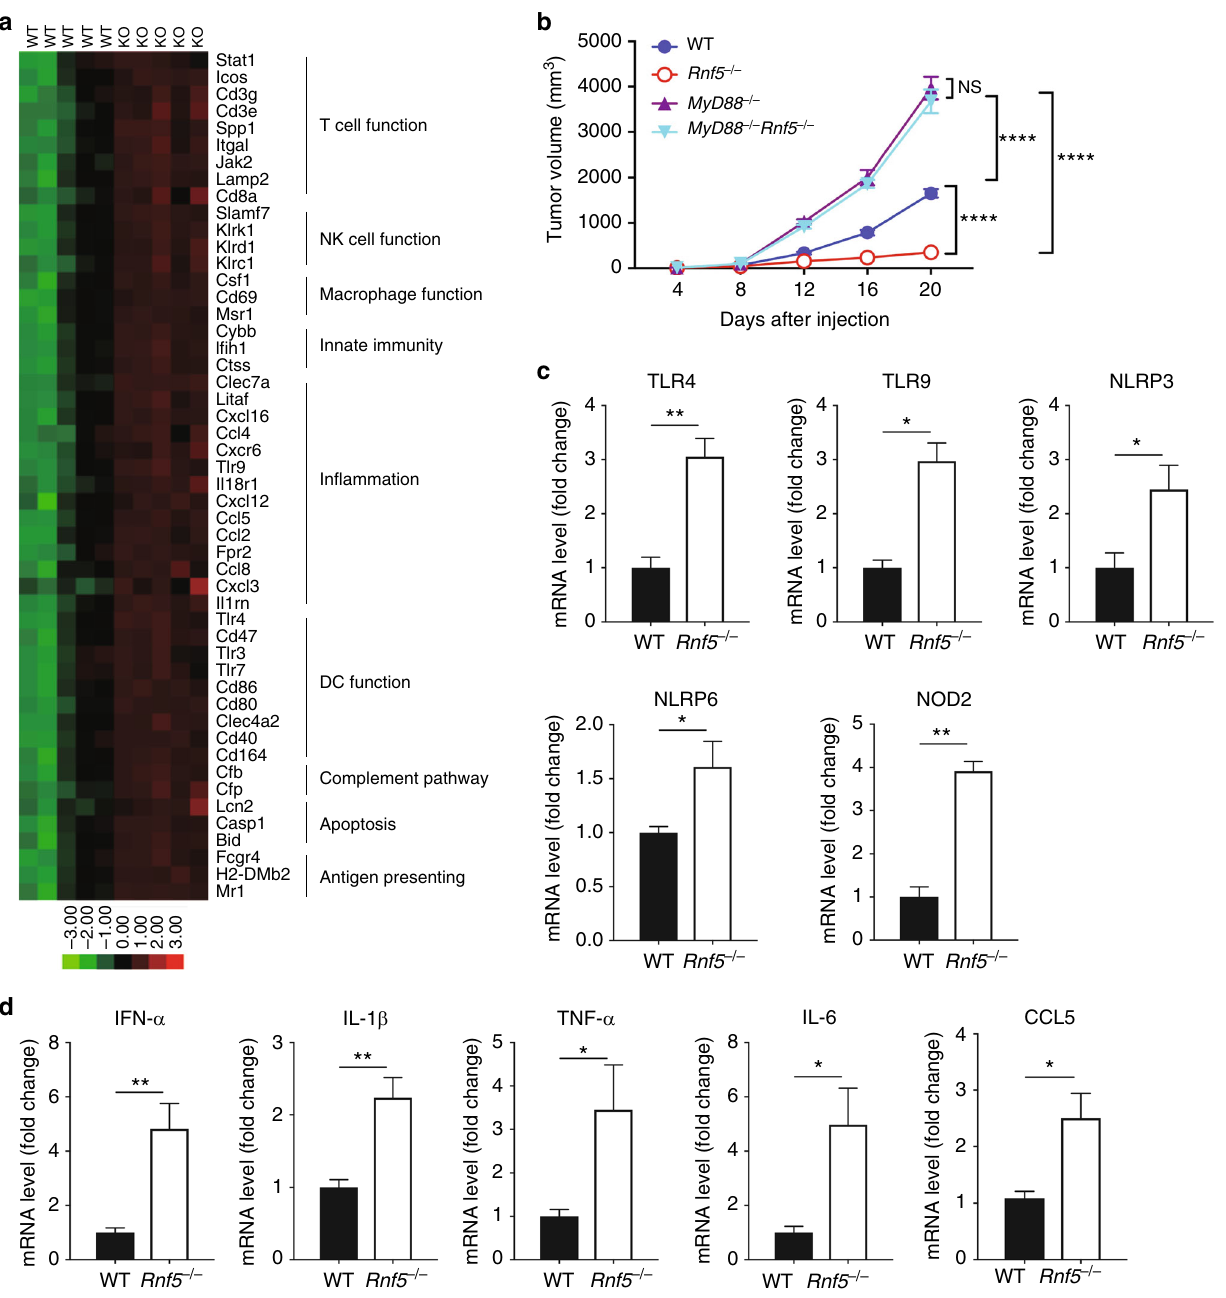
Fig. 2 Enhanced in fl ammasome and pathogen receptor signaling in Rnf5 − / − mice. a NanoString analysis of PanCancer Immune Pro fi ling genes in tumors from WT and Rnf5 − / − mice. The heatmap shows 47 genes with >1.2-fold ( P < 0.05) differences in expression between YUMM1.5 tumors from the two genotypes ( n = 5) at 10 days after injection. b Growth of B16F10 melanoma cells after subcutaneous injection of 10 6 cells into WT, Rnf5 − / − , MyD88 − / − and MyD88 − / − Rnf5 − / − mice (WT, Rnf5 − / − , n = 6; MyD88 − / − , n = 5; MyD88 − / − Rnf5 − / − , n = 8). c qRT-PCR analysis of pathogen receptor mRNA levels in IECs from tumor-bearing WT or Rnf5 − / − mice ( n = 4). d qRT-PCR analysis of cytokine and chemokine mRNA levels in IECs isolated from the small intestines of tumor-bearing WT or Rnf5 − / − mice ( n = 4). Data are representative of three independent experiments ( c , d ), two independent experiments ( b ) or one experiment ( a ) ≥ 5 mice per group. Graphs show the mean ± s.e.m. * P < 0.05, ** P < 0.005, *** P < 0.001, **** P < 0.0001 by two-tailed t test or Mann – Whitney U test ( c , d ) or two-way ANOVA with Sidak ’ s correction ( b )